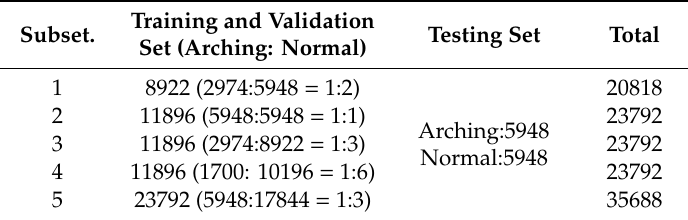
Table 2. Five subsets established for training and